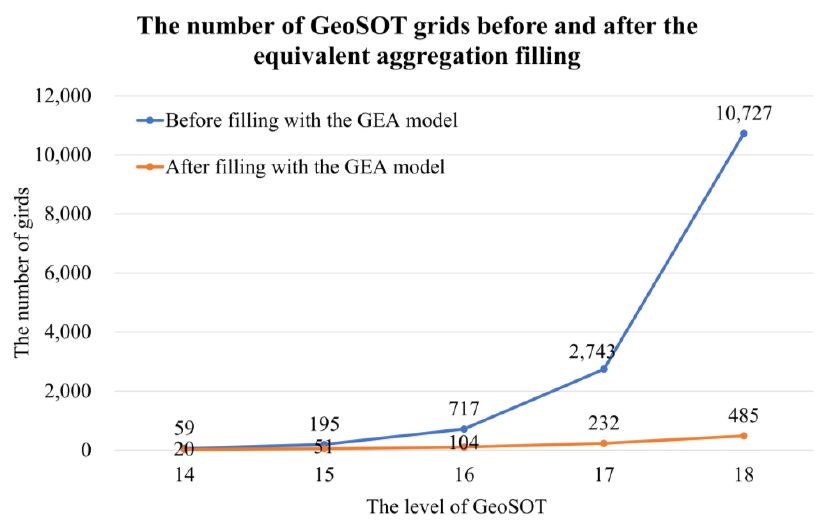
According to the particle small grid filling and equivalent aggregation filling of each hexagonal grid, we obtain the comparison of the number of GeoSOT grids before and after Figure 13. Index database associated with the GEA model. Figure 13. Index database associated with the GEA model. the equivalent aggregation filling (Figure 14).